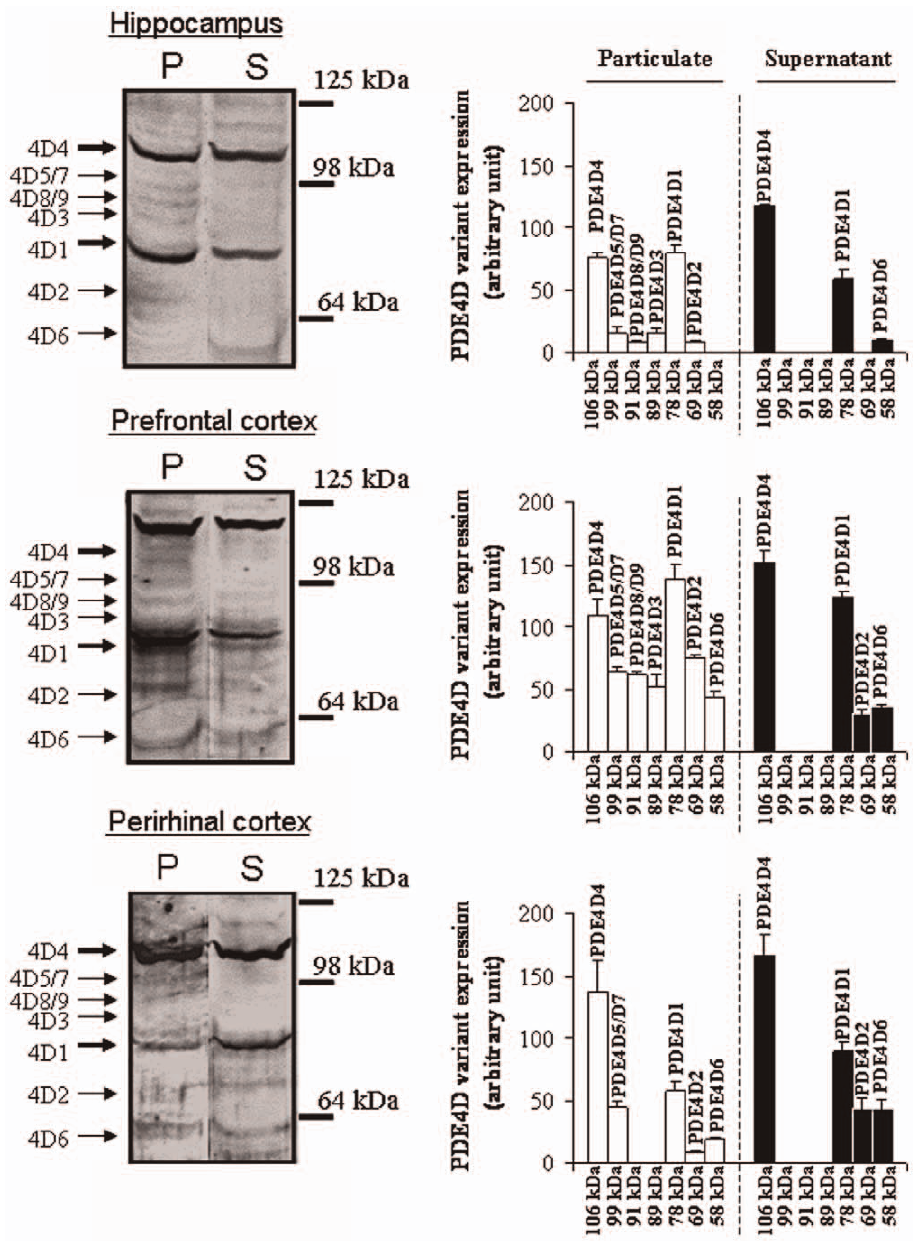
Figure 1. Expression of PDE4D proteins in the particulate and soluble fractions of rat hippocampus, prefrontal and perirhinal cortices. Particulate and soluble fractions from the rat hippocampus, the prefrontal cortex and perirhinal cortex were isolated and proteins extracted as described in Materials and Methods section. The left panel shows representative immunoblots of particulate (25 m g) and soluble (25 m g) protein fractions probed with goat polyclonal human anti-PDE4D antibody in the hippocampus, prefrontal and perirhinal cortices. Arrowheads indicate the molecular weights of the immunoreactive proteins. The right panel shows quantification; the intensities of the immunoreactive bands in the particulate and soluble fractions from hippocampus, prefrontal and perirhinal cortices were determined and normalized to those of actin. The densitometry values are the mean 6 SEM (n=3).